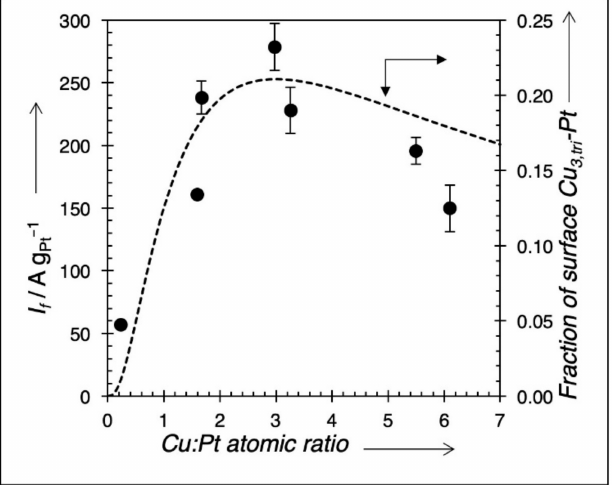
Figure 10. Calculated fraction (dashed line) of surface composed of Cu 3,tri –Pt pairs versus Cu:Pt ratio in shell overlaid with Pt mass activity for CH 3 OH